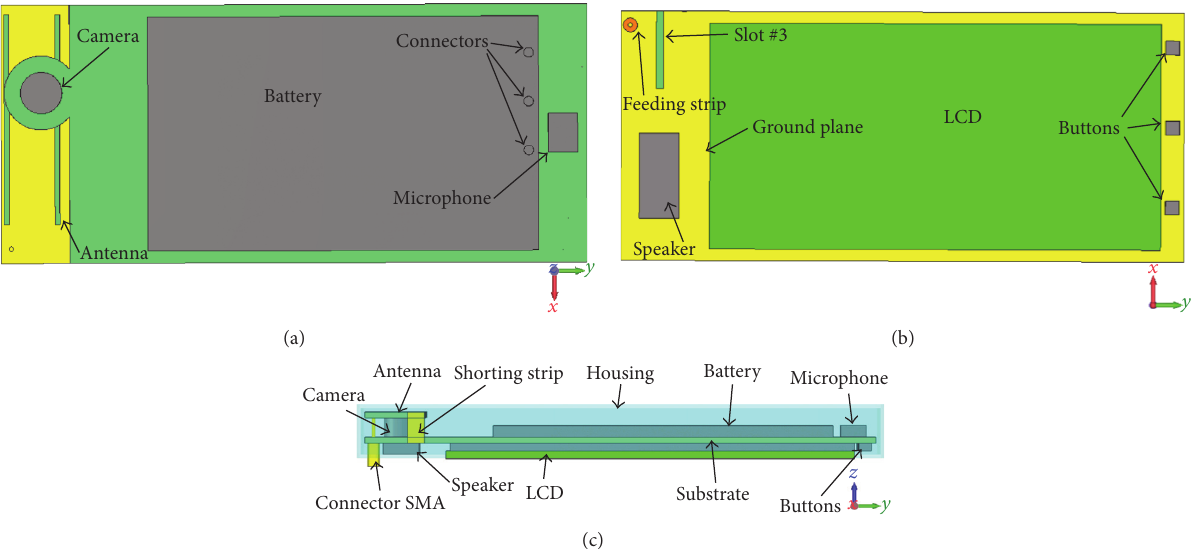
Figure 10: Structure of the mobile handset: (a) front view, (b) back view, and (c) side view.